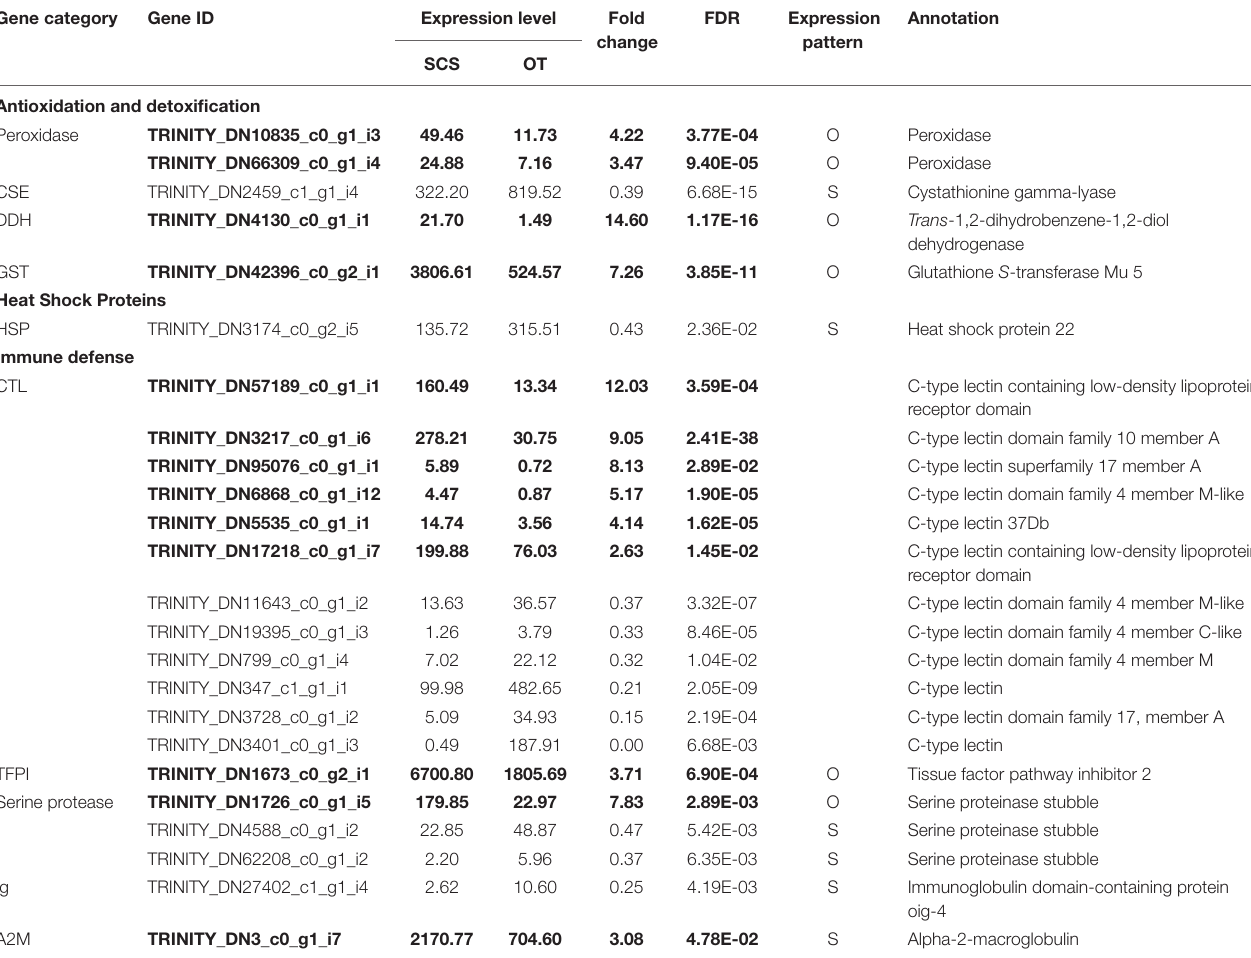
TABLE 6 | Comparison of DEGs involved in antioxidation and detoxification, heat shock proteins, and immune defense with those in the study of Cheng et al. (2020). Gene category Gene ID Expression level Fold